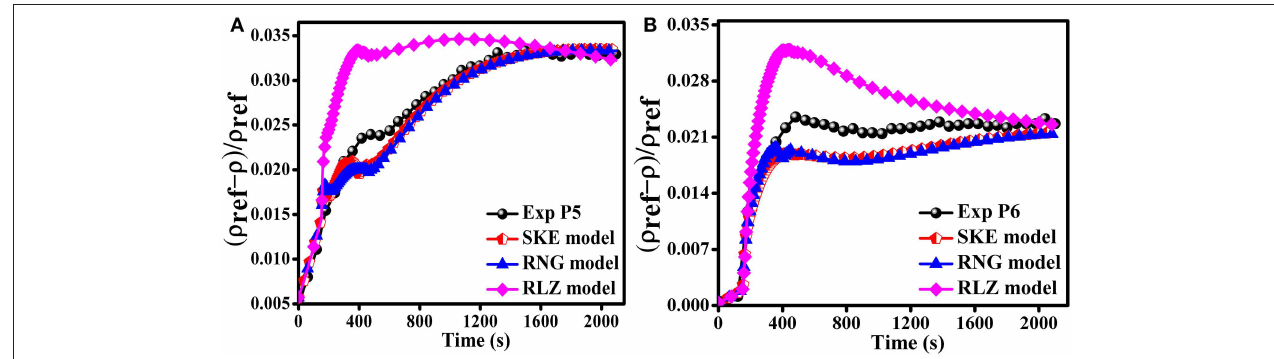
FIGURE 12 | Effect of turbulent diffusivity on numerical results calculated for SKE, RNG, and RLZ for monitors (A) P5 and (B) P6, at inlet velocity 2.803